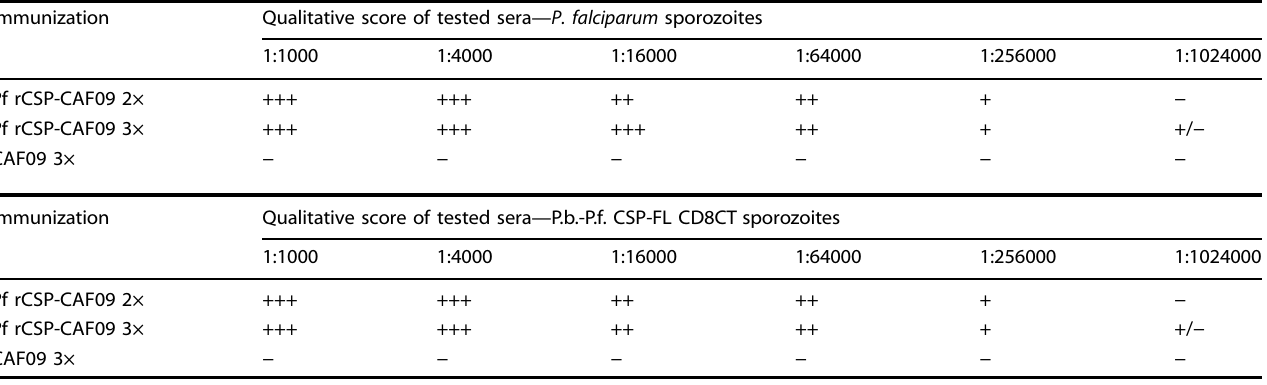
Table 1. Binding capacity of sera from Pf rCSP-CAF09-immunized mice to P. falciparum and P.b.-P.f. CSP-FL CD8CT transgenic sporozoites Immunization